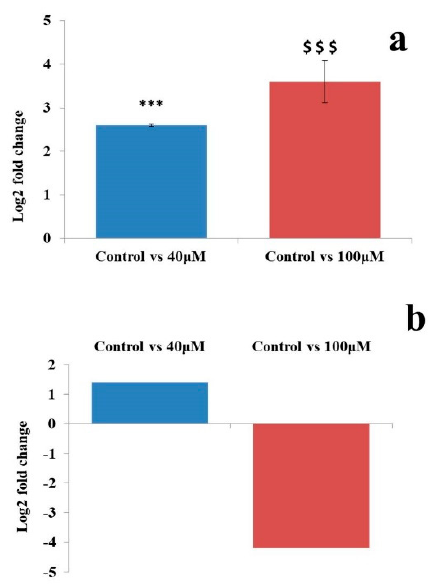
Figure 12. Validation of putative of novel microRNA TPP-A549-23 by qRT PCR. ( a ) Log2 fold change from qRT-PCR; ( b ) Log2 fold change from NGS dataset. Significant difference is indicated by ‘*’ between the untreated control and 40 µ M EGCG treatment and ‘$’ between the untreated control and 100 µ M EGCG treatment. Significance levels of p < 0.001 (‘***’; ‘$$$’) are denoted by repetition of these symbols.